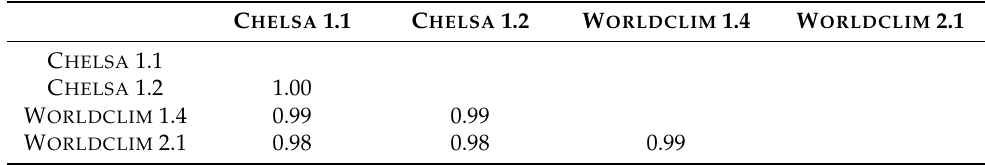
Table 2. Spearman rank correlation coefficients of Mean Temperature of the Wettest Quarter for all climate datasets and respective versions. All correlations were highly significant ( p ≤